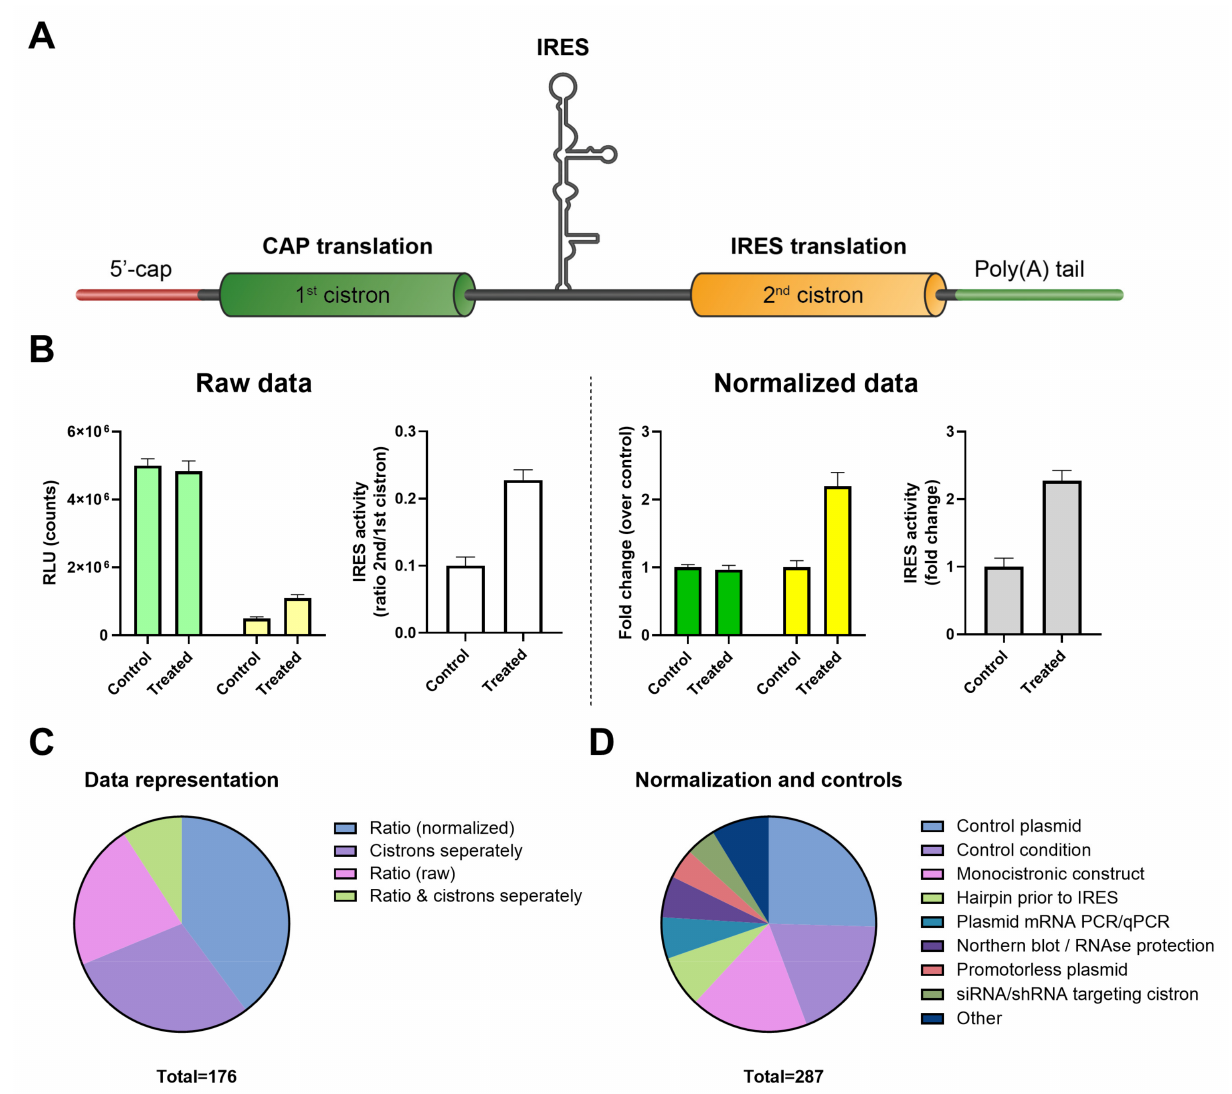
Figure 4. Data representation possibilities and overview. ( A ) Schematic of a bicistronic IRES reporter mRNA. ( B ) Visualiza- tion options for bicistronic data. Left: raw data from separate cistrons or the calculated ratio. Right: normalized cistrons separately and a normalized ratio. The latter is easier to interpret, however, relevant information is also lost about the measurement and relative signal differences. ( C ) Data representation in analyzed publications. ( D ) Normalization strategies and control use. Note that multiple normalization strategies or controls were combined in a large number of studies. The prevalence of the top eight normalization or control methods is depicted in the pie